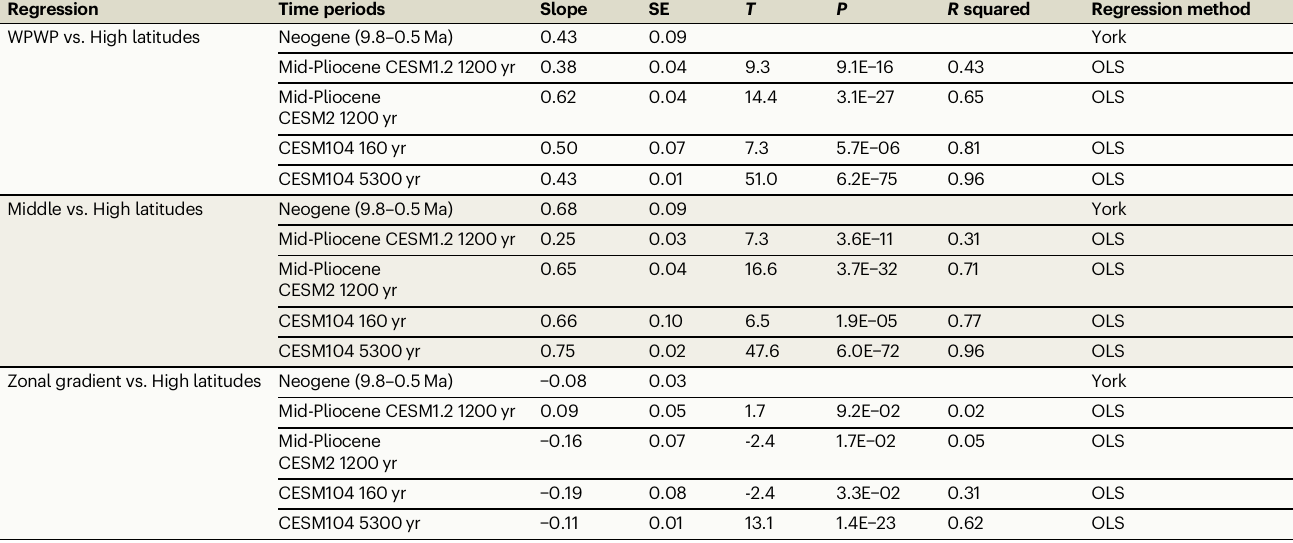
Table 1 | Statistical analyses of the linear regressions shown in Fig. 3 and 5